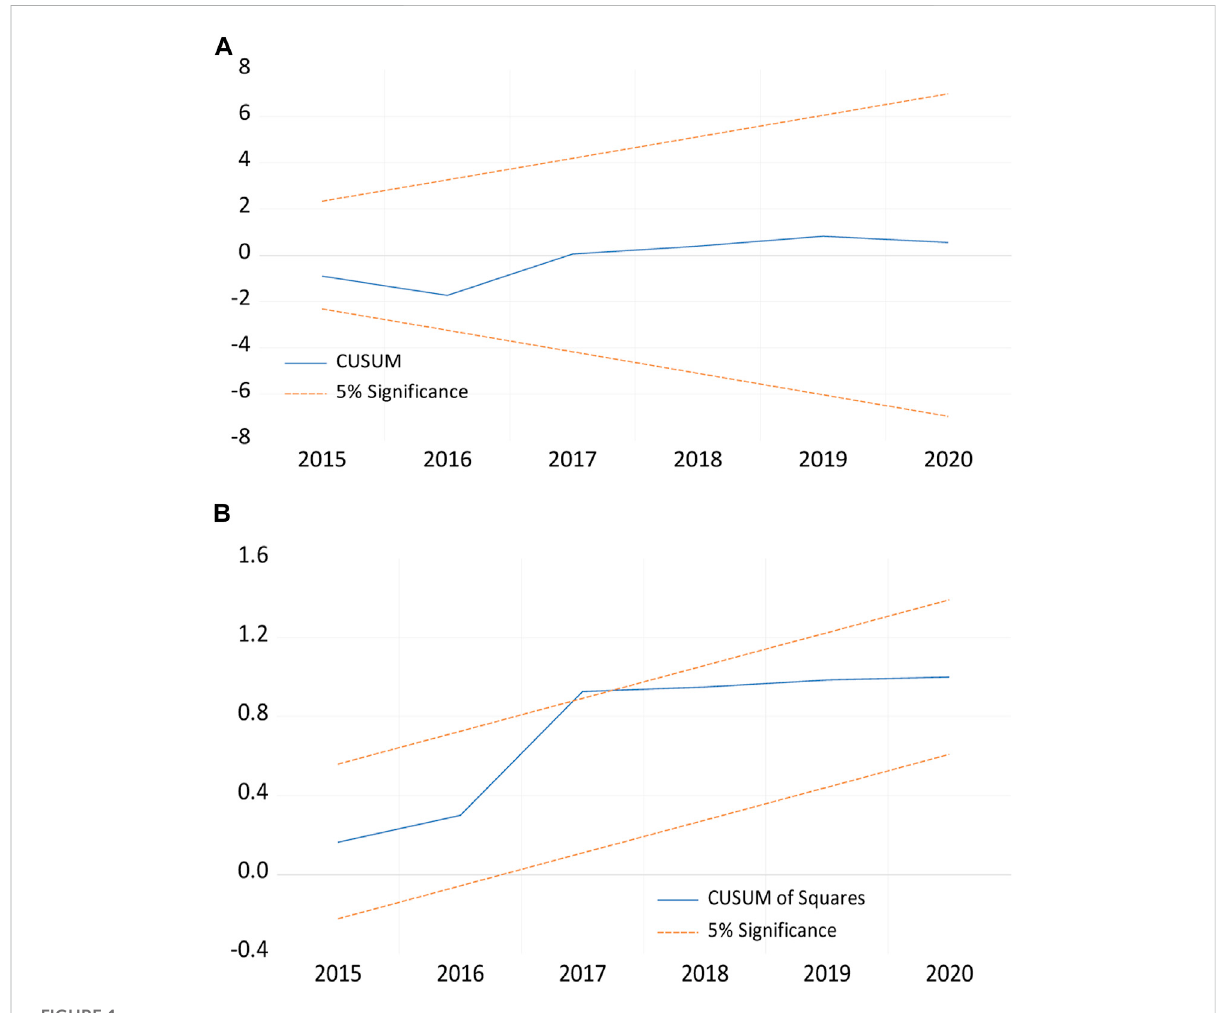
FIGURE 1 (A) Test result of CUSUM. (B) Test result of